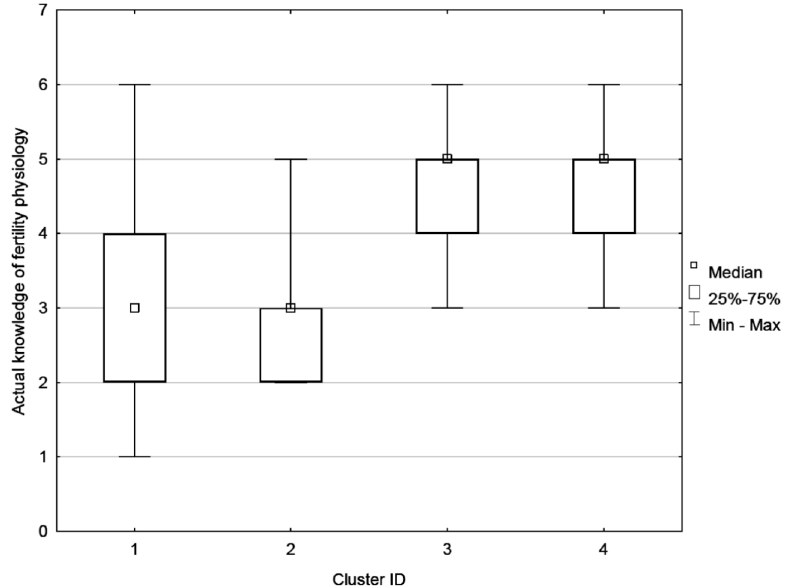
Figure 3. Level of actual knowledge about the physiology of fertility for each